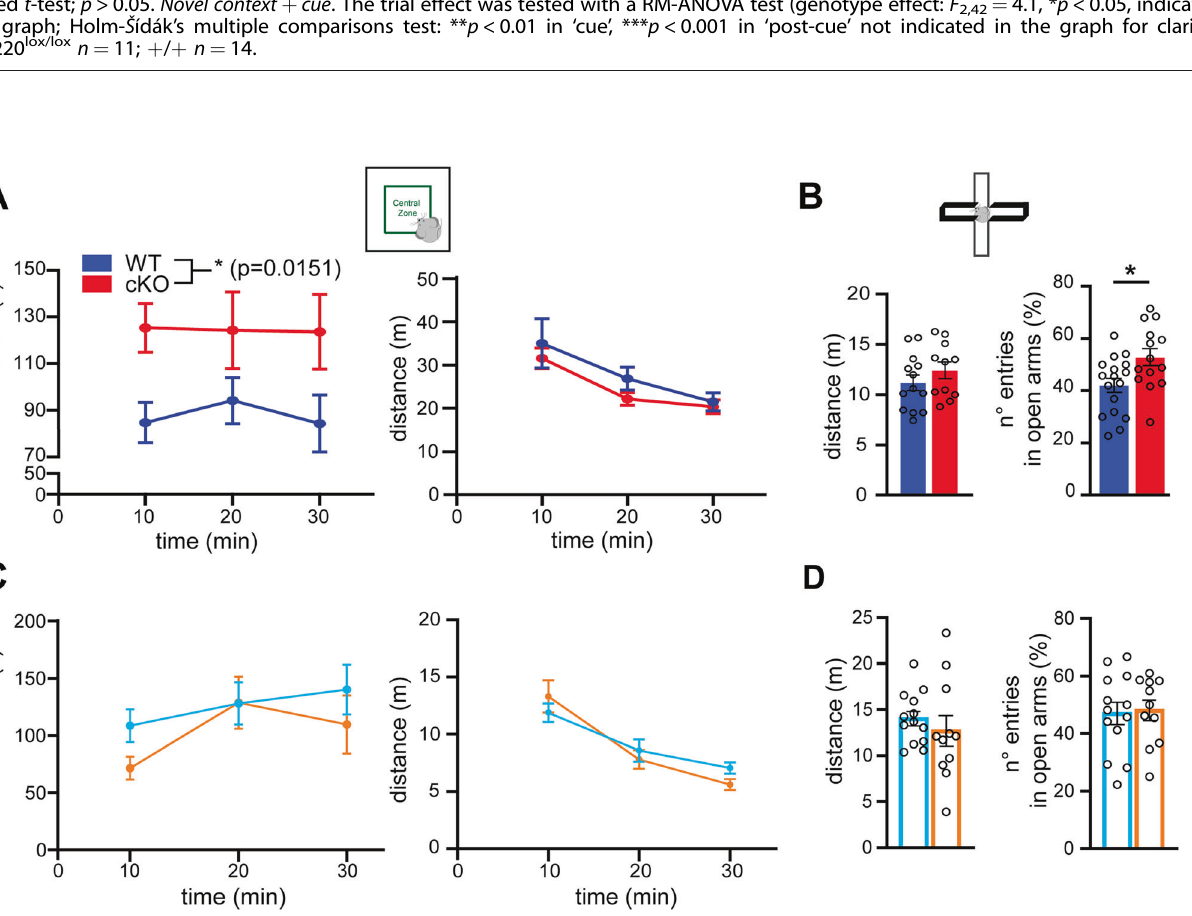
Fig. 5 Anxiety is reduced in cKO mice. A Open Field in cKO mice. Schematic representation of the test (top) and quanti fi cation of the distance traveled (bottom right) and of the time spent in the central zone (bottom left). The quanti fi cation is expressed as the time (s) spent in the central zone every 10 min throughout the 30 min trial. Values are plotted as mean ± S.E.M. The genotype effect was tested with a RM- ANOVA test ( F 1, 37 = 4.568, * p < 0.05). cKO n = 19; WT n = 21. B . Elevated plus Maze in cKO mice. Schematic representation of the test (top) and quanti fi cation of the distance traveled ( bottom left ) and the n . of entries in the open arms during the 5 min test (bottom right). The quanti fi cation is expressed as percentage of the number of entries in the open arms over the total n . of entries. The genotype effect was tested with Student ’ s unpaired t -test; * p < 0.05. cKO n = 14; WT n = 17. C Open Field in Kidins220 lox/lox . The experiment was performed and quanti fi ed as in A . The behavior is comparable among genotypes ( F 1,21 = 0,1164; p > 0.05 genotype effect, RM-ANOVA). Kidins220 lox/lox n = 9; + / + n = 10. D . Elevated plus Maze in Kidins220 lox/lox . The experiment was performed and quanti fi ed as in B . Both the distance traveled and the percentage n . entries in open arms are comparable among genotypes (Student ’ s unpaired t -test; p > 0.05). Kidins220 lox/lox n = 11; + / + n = 13. In all panels, values are plotted as mean ± S.E.M. and individual values are represented with circles. Cell Death Discovery (2022)